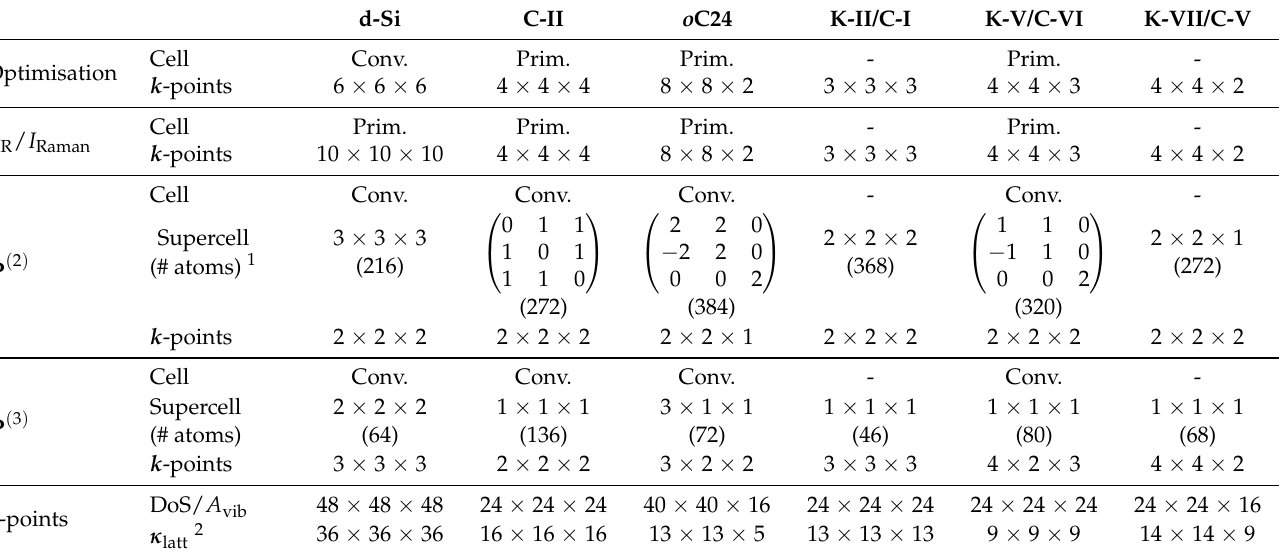
Table 1. Summary of the technical parameters used in calculations on the six structures examined